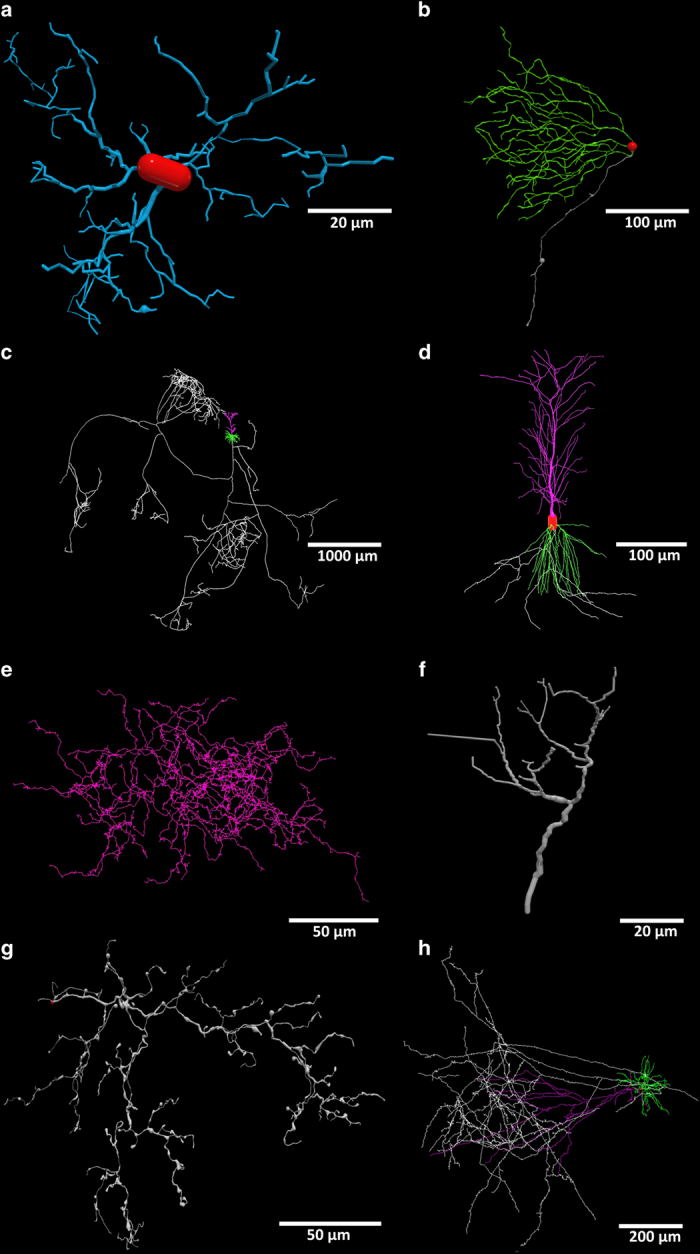
Digital reconstructions of cellular morphologies in NeuroMorpho.Org.(a) Microglia cell from mouse spinal cord52, with processes in blue and cell body in red (Data Citation 1). (b) Ganglion cell from mouse retina53, with dendrites in green, axon in silver, and soma in red (Data Citation 2). (c) Pyramidal neuron from mouse neocortex54, with apical dendrites in magenta, basal dendrites in green, and long projection axon in silver (Data Citation 3). (d) Pyramidal neuron from rat hippocampus55, with apical dendrites in magenta, basal dendrites in green, and (incomplete) axon in silver (Data Citation 4). (e) Interneuron from mouse retina56, with unspecified neurites in pink (Data Citation 5). (f) Direction sensitive mechanoreceptor from cricket peripheral nervous system, with unspecified neurites in pink57 (Data Citation 6). (g) Olivocerebellar neuron from rat myelencephalon, with axon in silver58 (Data Citation 7). (h) Pyramidal neuron from cat neocortex59, with apical dendrites in magenta, basal dendrites in green, and long projection axon in silver (Data Citation 8).